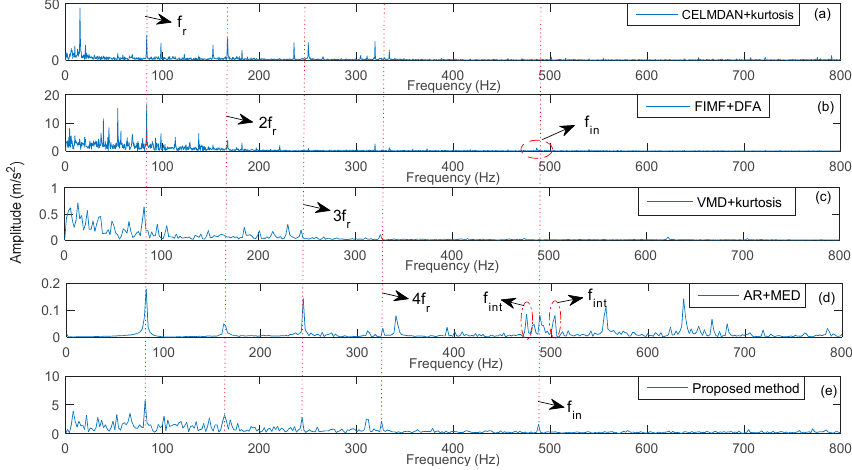
Figure 31. Identified fault frequency of a rolling bearing at 5000 RPM.